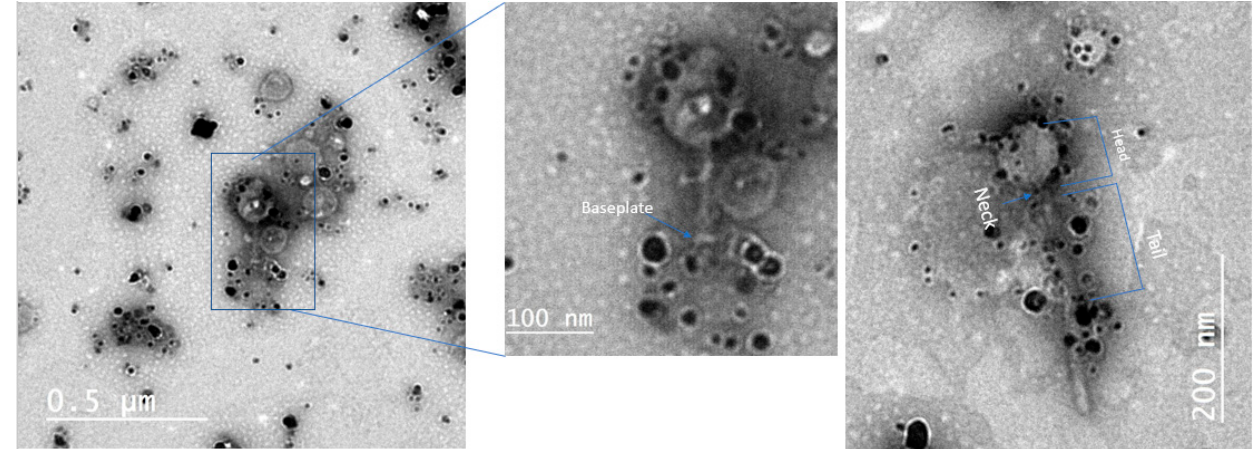
Figure 4. Shows the interaction between phage and biosynthesized